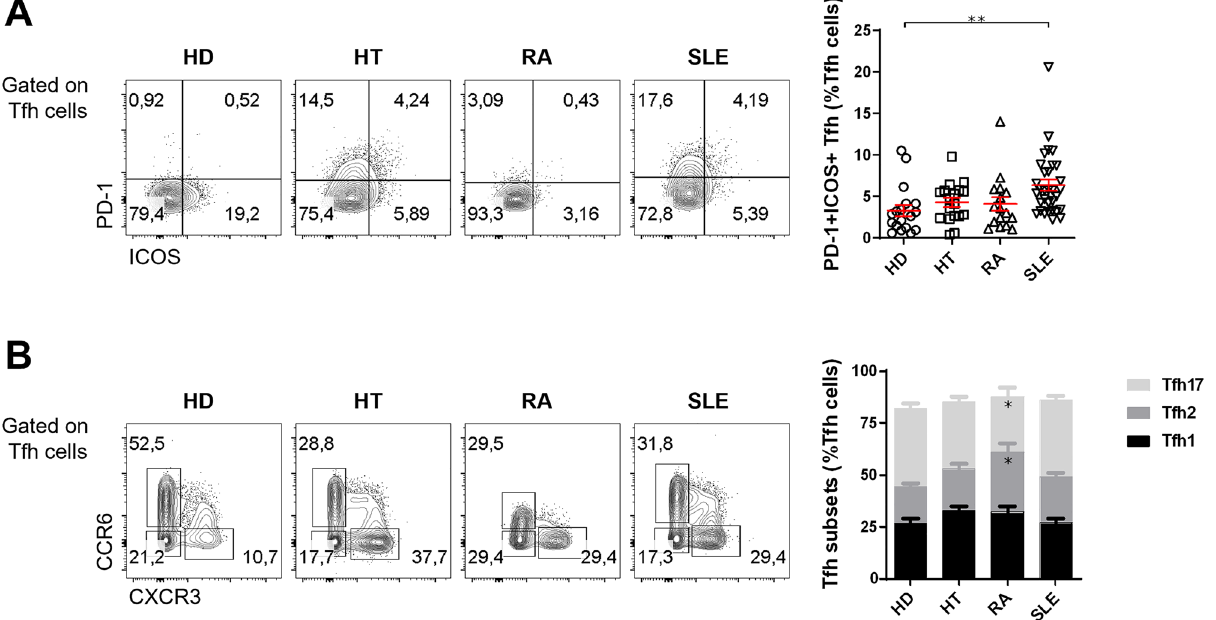
Figure 2. Activated PD-1 + ICOS + Tfh cells are expanded in SLE patients. (A) Representative plots (left) and pooled data (right) of the frequency of activated PD-1 + ICOS + Tfh cells in the peripheral blood of HT (n = 18), RA (n = 16), and SLE (n = 32) patients, and sex- and age-matched HD (n = 18). Each data point represents an individual subject; bars represent mean ± SEM; * p < 0.05, ** p < 0.01, *** p < 0.001, Kruskal–Wallis one-way analysis of variance (ANOVA) test with Dunn’s comparison post-test (B) Representative plots (left) and pooled data (right) of the distribution of Th1-like (CXCR3 + CCR6 – ), Th2-like (CXCR3 – CCR6 – ), and Th17-like (CXCR3 – CCR6 + ) Tfh cell subsets in HT (n = 18), RA (n = 16), and SLE (n = 32) patients, and sex- and age-matched HD